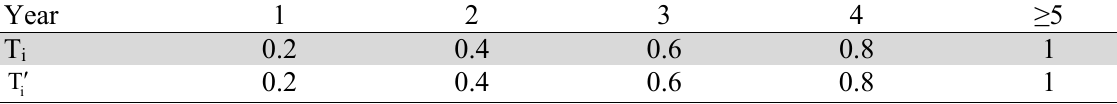
The scores assigned for the number of years of holding ISO